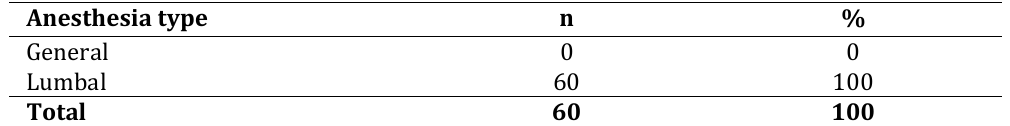
Characteristic respondent that consisted of Anaesthetic Type Towards Post Sectio Caesarea Mothers Anesthesia type